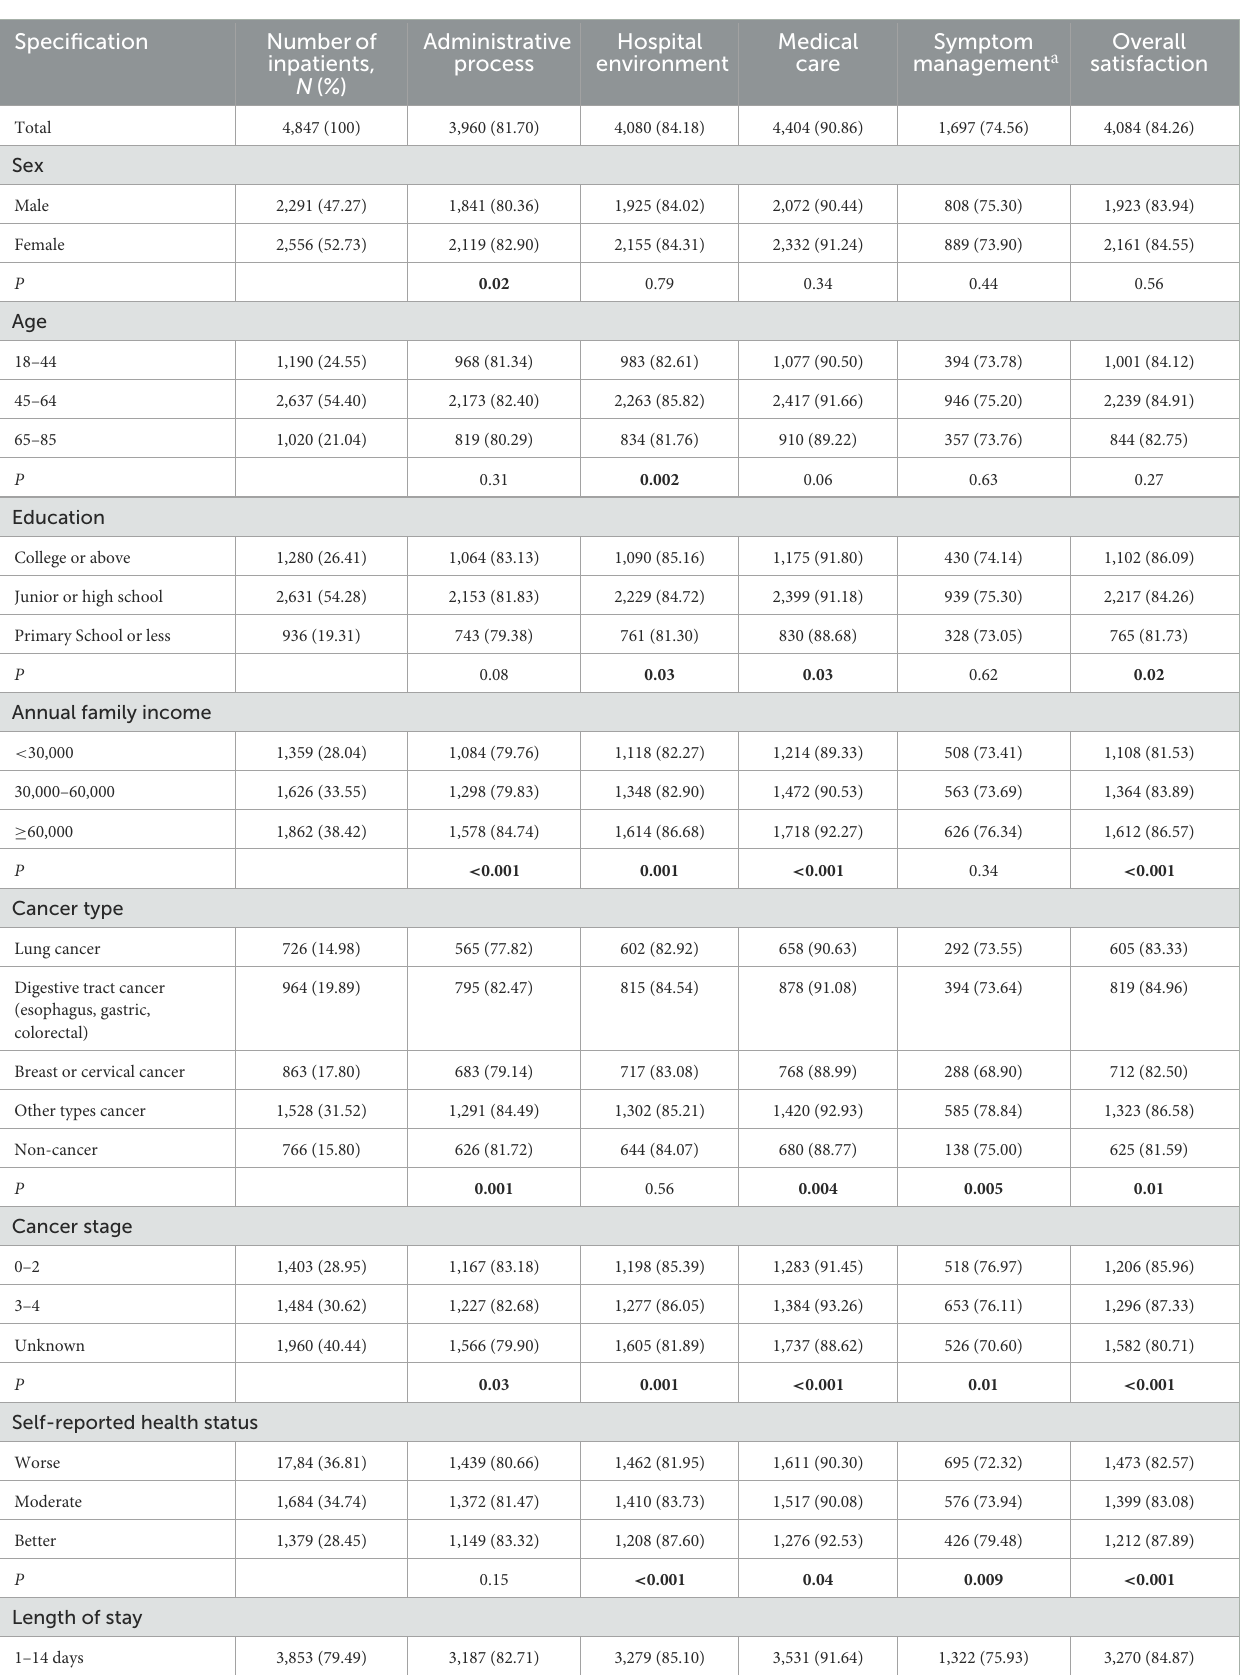
TABLE 2 Patient characteristics and the rate of patient